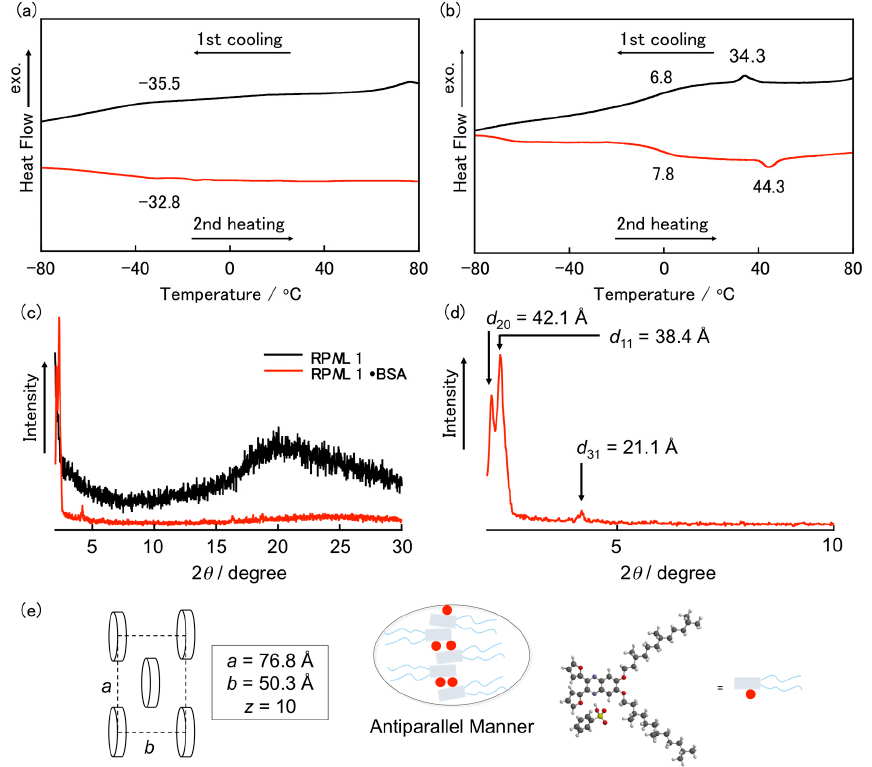
Figure 3. Differential Scanning Calorimetry (DSC) traces of the ( a ) RP N L 1 and ( b ) RP N L 1·BSA, on a scanning rate of 10 K/min; ( c ) XRD patterns of RP N L 1 and RP N L 1·BSA at 25 °C; ( d ) XRD pattern of the magnified view for RP N L 1 · BSA; and ( e ) Predicted schematic illustration of the molecular packing for RP N L 1 · BSA in a disc-like stratum of a